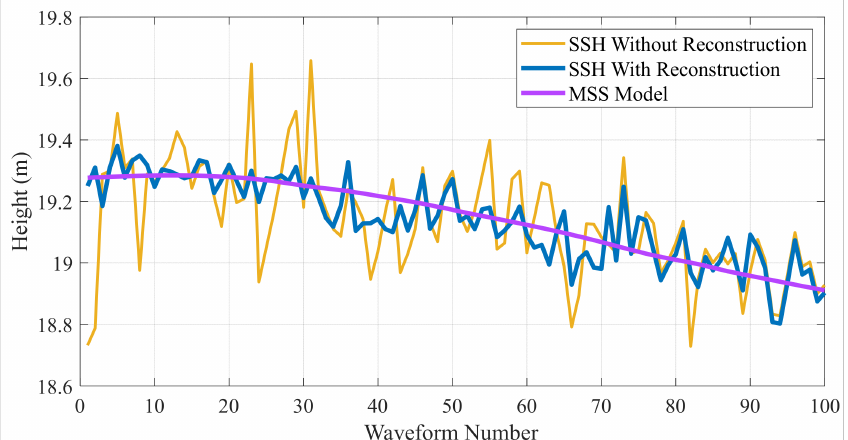
Figure 15. Validation of retrieved SSH data using the MSS model. The yellow and blue lines represent the SSH retrieval results of the original and reconstructed waveforms, and the purple line represents the MSS